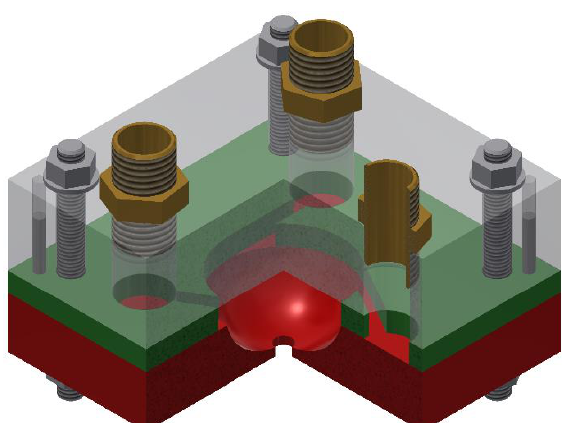
Fig. 2. Model of the scaled transparent